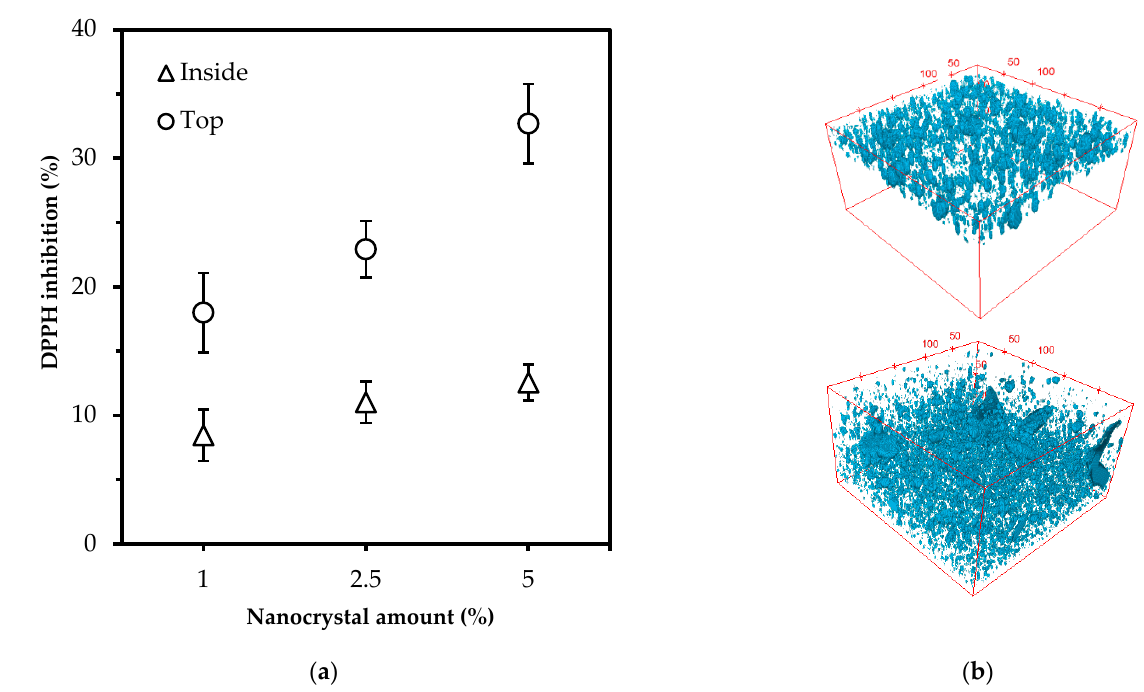
Figure 4. ( a ) DPPH inhibition (%) of ChNC/PLA nanocomposites after 8 h incubation time; ( Δ ) particles dispersed inside the plastic, (o) particles at the surface of the plastic; ( b ) CLSM micrographs of calcofluor white labelled ChNC in PLA (dimensions; 250 × 250 × 140 µm), and on top of PLA (1% on top, 5% inside the matrix, respectively).